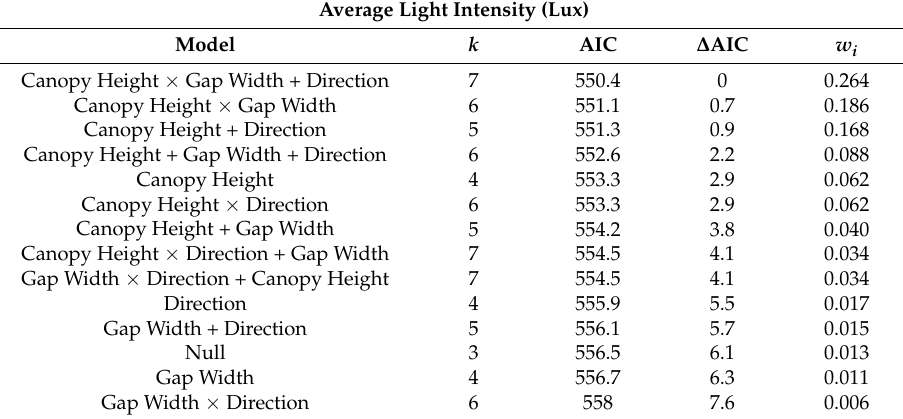
Table A1. Generalized Linear Mixed Models for average light intensity along seismic lines. Models reflect combinations of canopy height, gap width, and line orientation. Results are in ascending order of AIC weight. Number of parameters ( k ), delta AIC, and likelihood of the model as Akaike weighs ( w i ) are